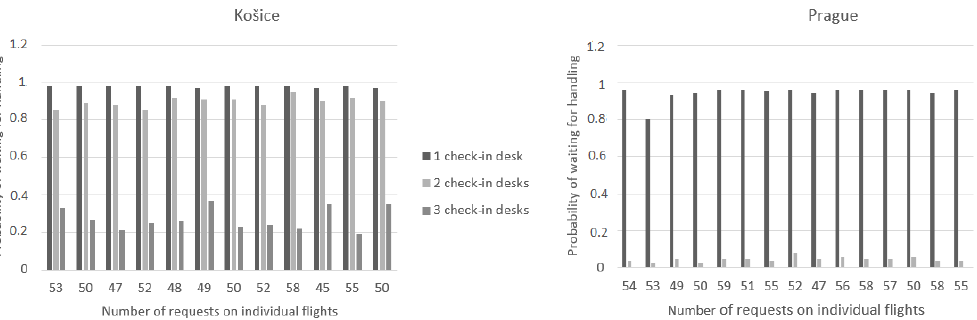
Figure 6. Probability of waiting for handling when changing the number of check ‐ in desks.